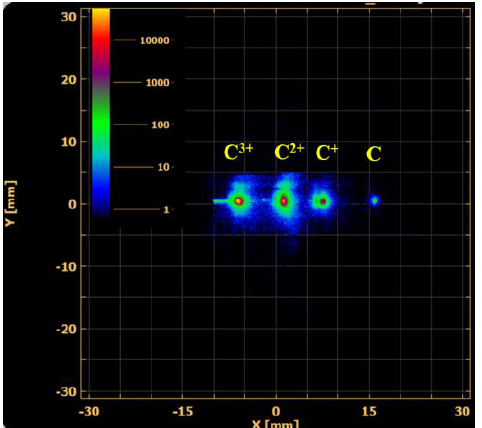
Figure 1. Schematic diagram of electron capture experimental setup. MCP: micro channel plate; FC: Faraday cup.